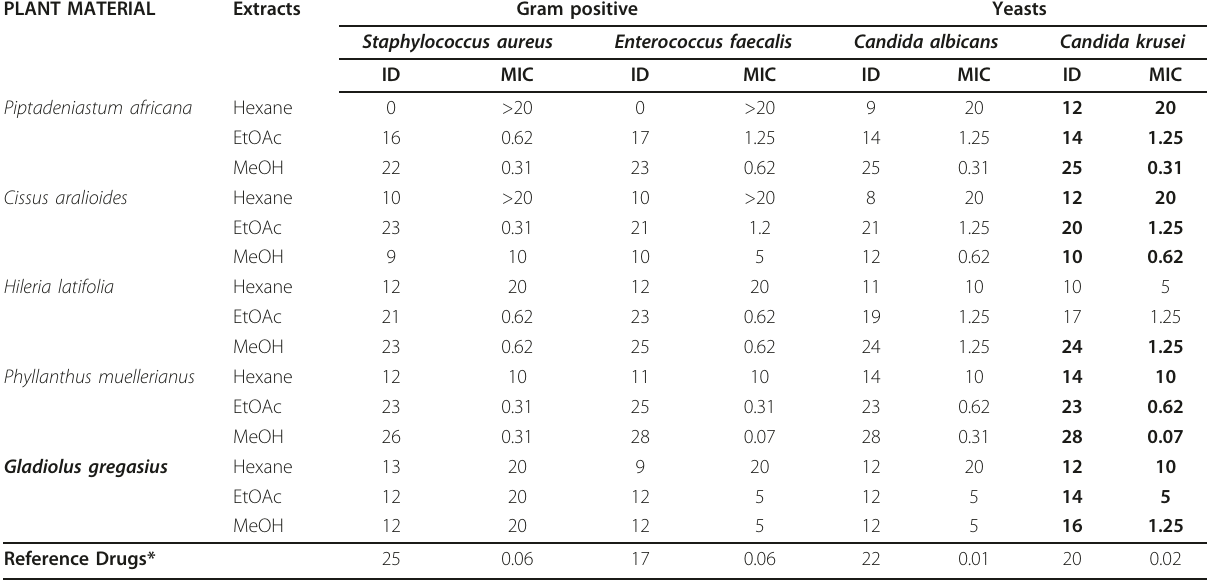
Table 3 Inhibition zone diameters (ID in mm) and minimal inhibitory concentration (MIC in mg/ml) of hexanic, ethylacetate and methanolic extracts of five medicinal plants against Gram positive bacteria species and yeasts strains PLANT